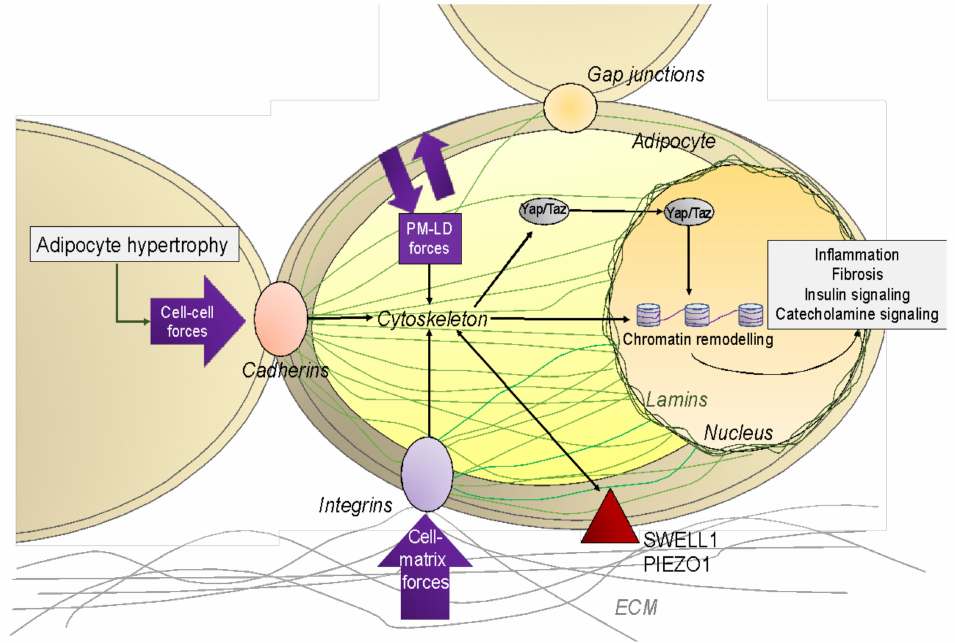
Figure 1. Mechanosensing mechanisms in adipose tissue. Adipocytes receive mechanical forces at the cell plasma membrane arising from the surrounding extracellular matrix (ECM) or from neighboring cells via integrins, cadherins, GAP junctions or other mechanosensitive proteins such as SWELL1 or PIEZO channels. Mechanical cues can emanate from cell–cell adhesion, cell–ECM adhesion, cytoskeleton remodeling (actomyosin, stress fiber, etc.) and from the growth of lipid droplet (plasma membrane (PM)–lipid droplet (LD) forces) that stiffen the cells (purple arrows). Force sensing and transmission at cell–ECM and cell–cell adhesions converge on the cytoskeleton and can directly be transmitted to the nucleus, resulting in chromatin remodeling and transcriptional changes to modulate cell phenotype (inflammation, fibrosis, insulin resistance, and catecholamine